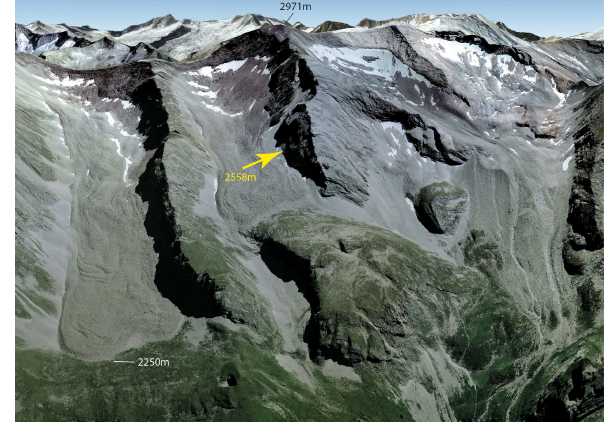
Figure 2. Oblique aerial view of the setting of the MSK Cave (entrance marked by the yellow arrow) at the Tuxer Hauptkamm, Zillertal Alps. Note active rock glaciers occupying the cirques and reaching down to 2250m in case of the rock glacier in the left cirque. View to the southeast (Google Earth Pro